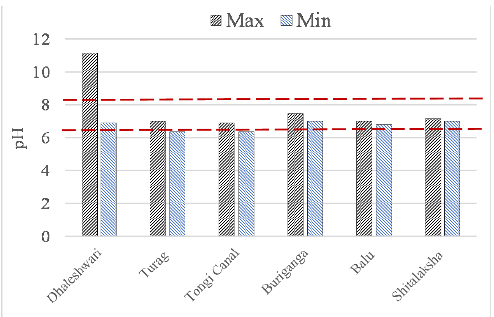
Figure 3. Max m vs. Min m Concentrations of pH for the peripheral rivers of Dhaka with WHO standards in dotted lines (6.5–8.5).